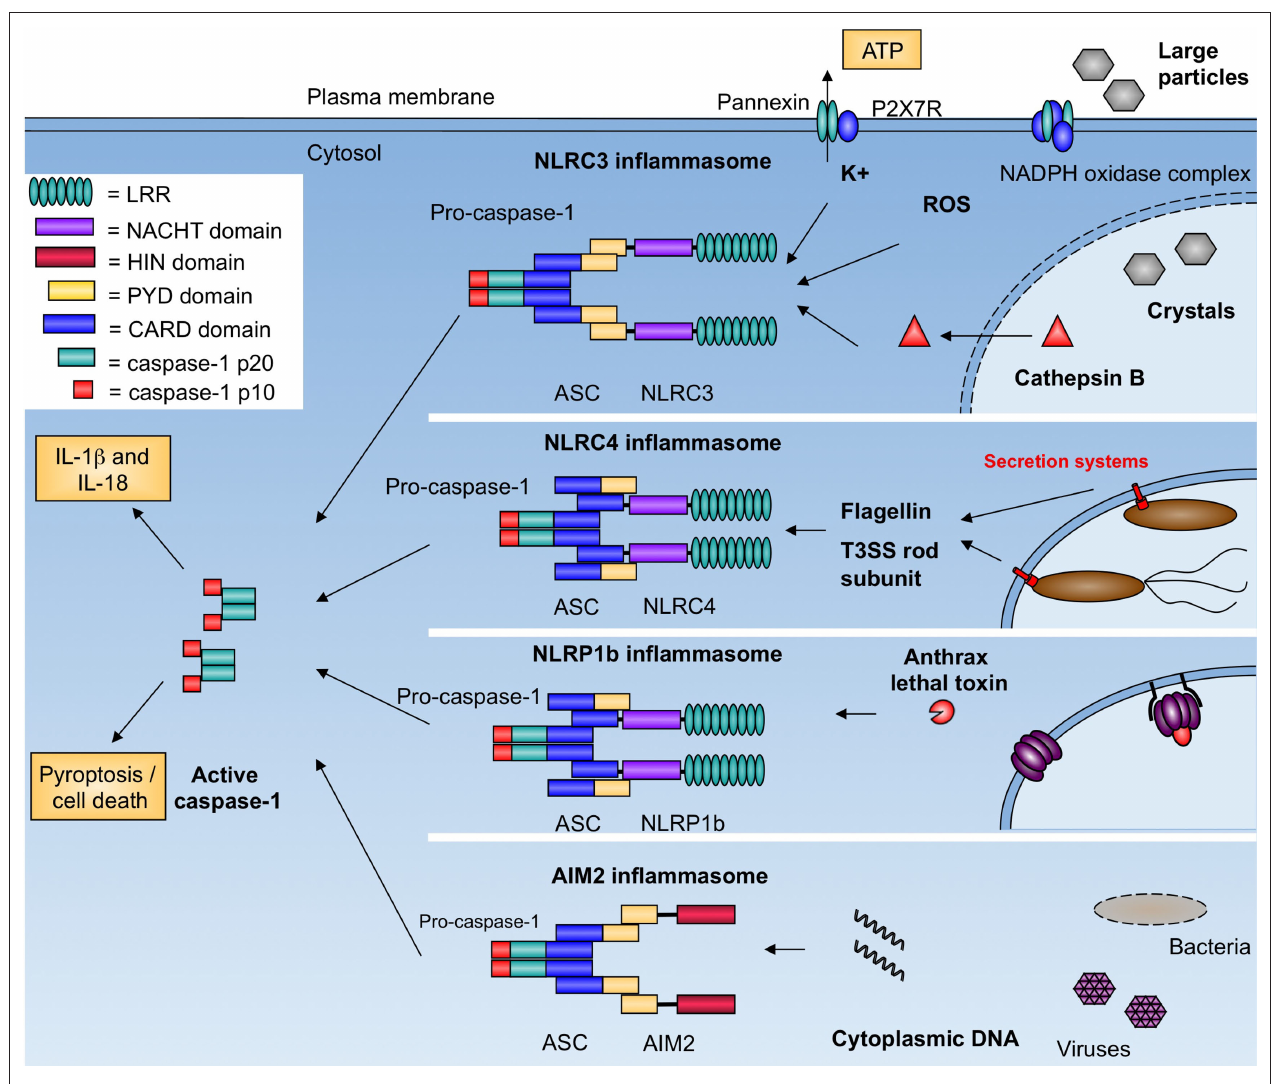
anthrax lethal factor. AIM2 binds cytosolic dsDNA from bacterial, viral, mammalian, and synthetic sources. Complexes are formed through homotypic interactions (LRR, leucine rich repeats; HIN, hemopoietic IFN-inducible nuclear proteins; PYD, pyrin; CARD, caspase activation and recruitment domain).